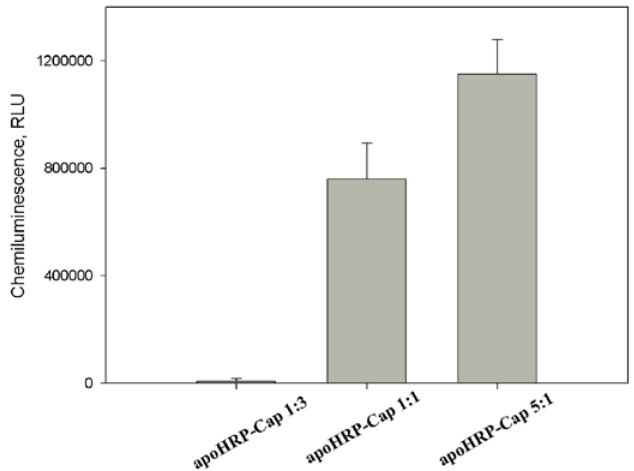
Figure 2. Effect of a molar ratio of the reacting compounds at the synthesis of apoHRP-CAP on the activity of the produced conjugates. Experimental conditions: concentrations of apoHRP-CAP, HBV DNA and HRP-REP were 5 µg/mL, 1 nM and 10 nM, respectively. Chemiluminescence was measured 8 min after the initiation of luminol oxidation. Each measurement was repeated thrice.